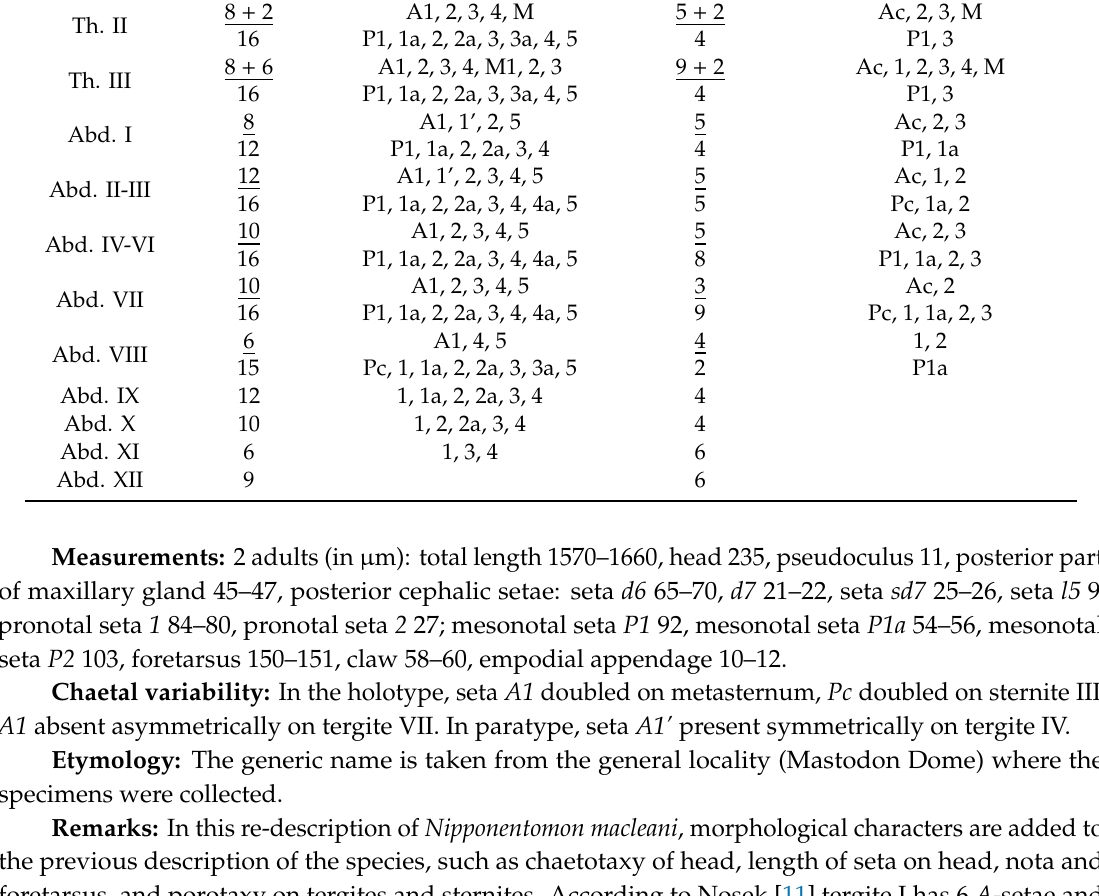
Table 2. Body chaetotaxy of Mastodonentomon macleani (Nosek, 1977). Dorsal Ventral Segment Formula Setal Composition Formula Setal